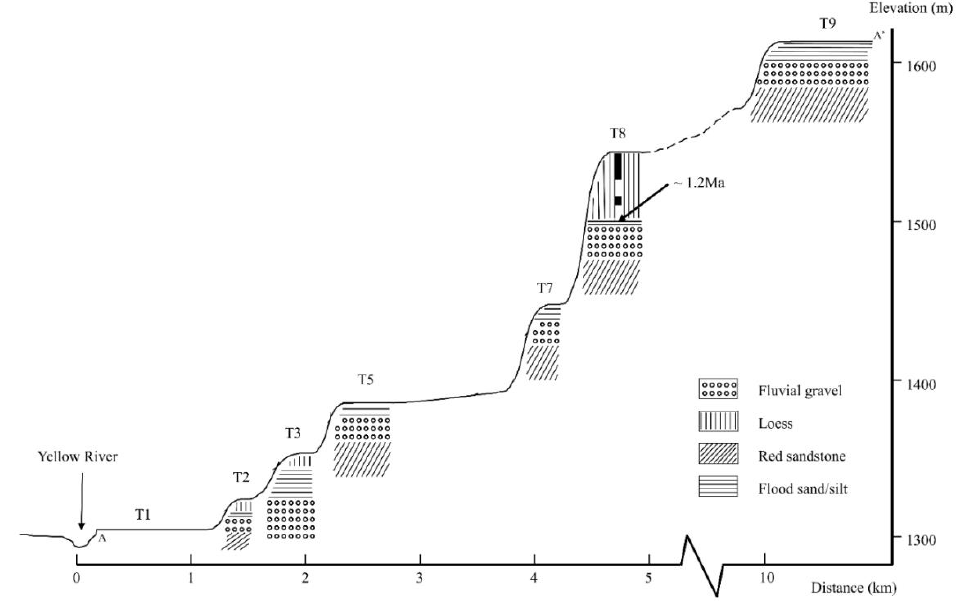
Figure 4. Schematic cross-section of the fluvial terrace staircase at the NGC site (see A-A’ in Figure 3). The top of the gravel layer at terraces T2, T3, T5, T7, T8, T9 above the floodplain of the modern Yellow River are 10–20 m, 25 m, 70 m, 154 m, 190 m, and 300 m, respectively.